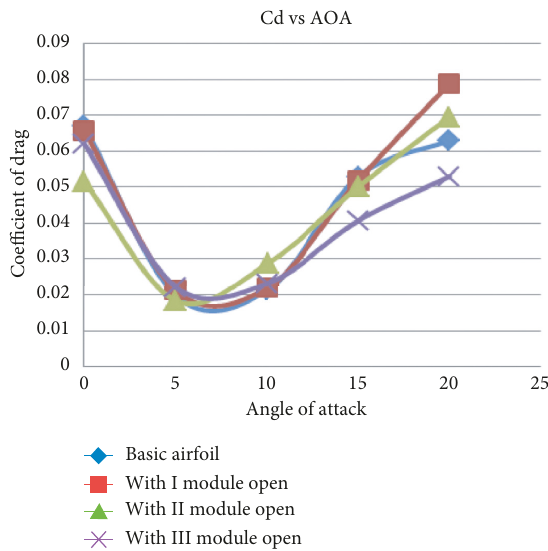
Figure 19: Plot between C